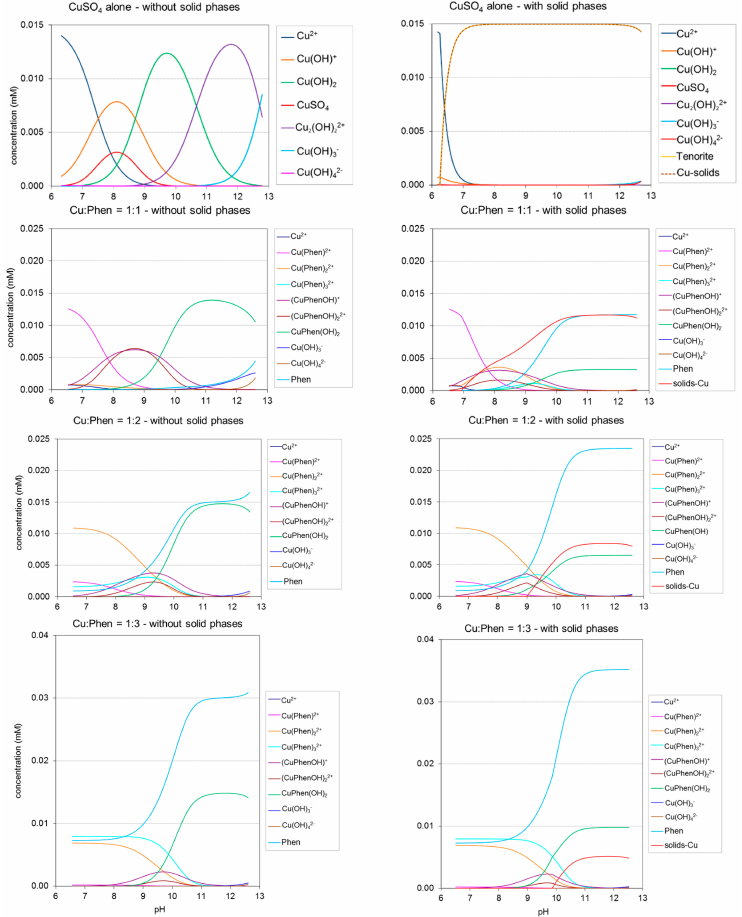
Figure 4. Calculated distributions of different species in CuSO 4 and Cu-Phen solutions as a function of pH. CuSO 4 alone, Cu:Phen = 1:1, 1:2 and 1:3; initial CuSO 4 concentration [Cu] = 15 µ M at 25 ◦ C, with or without the occurrence of